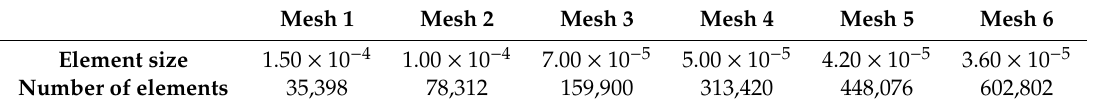
Figure 7. In silico division for computational model analysis of phases 1 and 2 according to the upward and downward stages. Table 2. Number and size of elements for the six different mesh configurations used for mesh convergence analyses. The element size edge was modified to obtain such configurations.